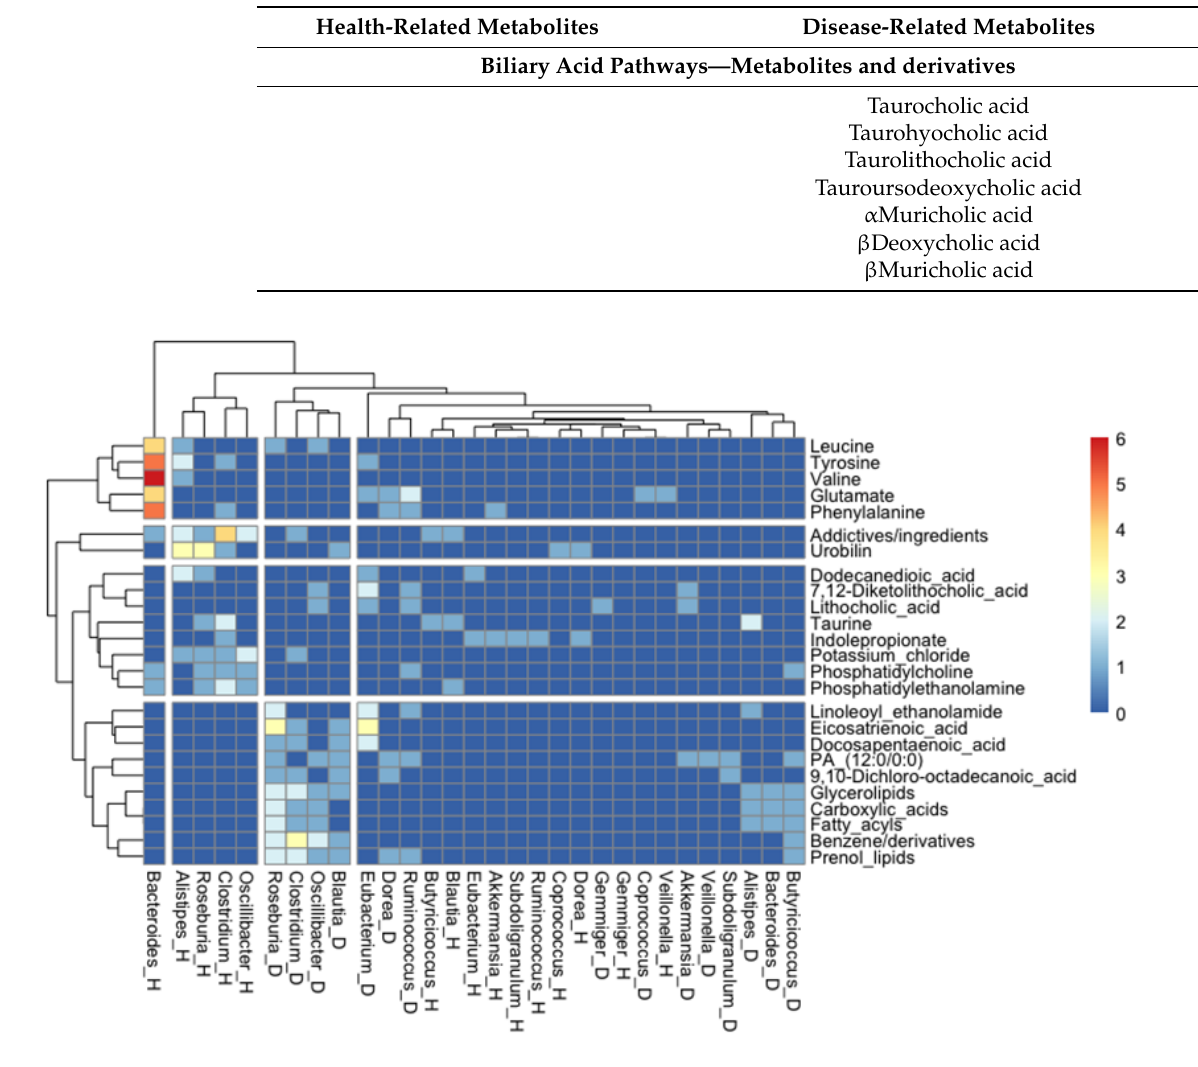
Figure 7. Heatmap showing the analysis where specific associations between a metabolite and a bacterial genus was found in a health and/or a disease stage (as indicated by “_H” or “_D”, respectively). For simplicity, only the representative genera and the most found metabolites were included.